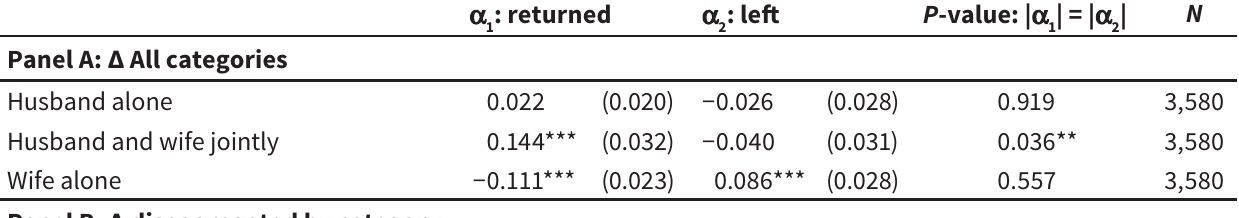
Dynamic shifts in decision-making power between husband and wife: first-difference approach